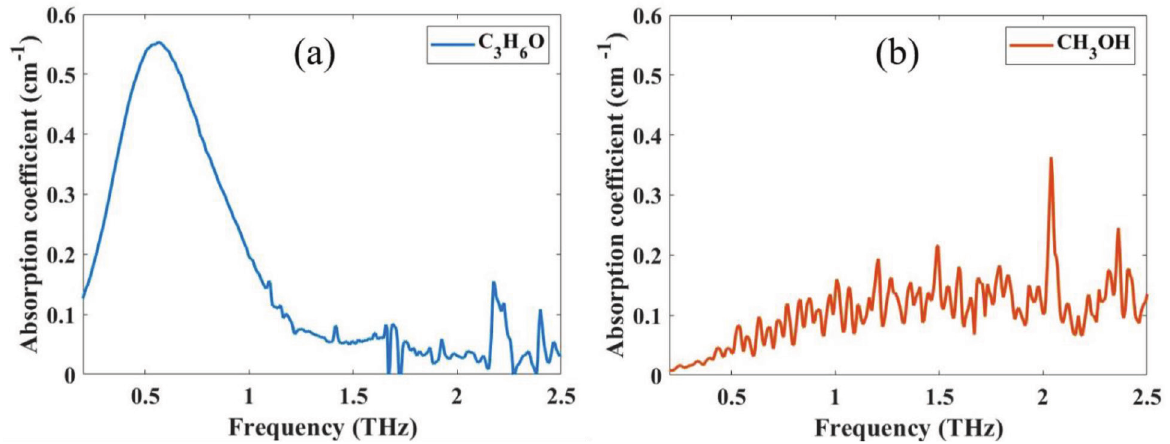
OH absorption coefficients in gaseous phase within 0.2-2.5 THz range (15 GHz spectral resolution). The Figure 9: (a) Acetone and (b) CH 3 measurements were performed with the THz-TDS setup at Terahertz laboratory, University of Rome ‘La Sapienza’ (original